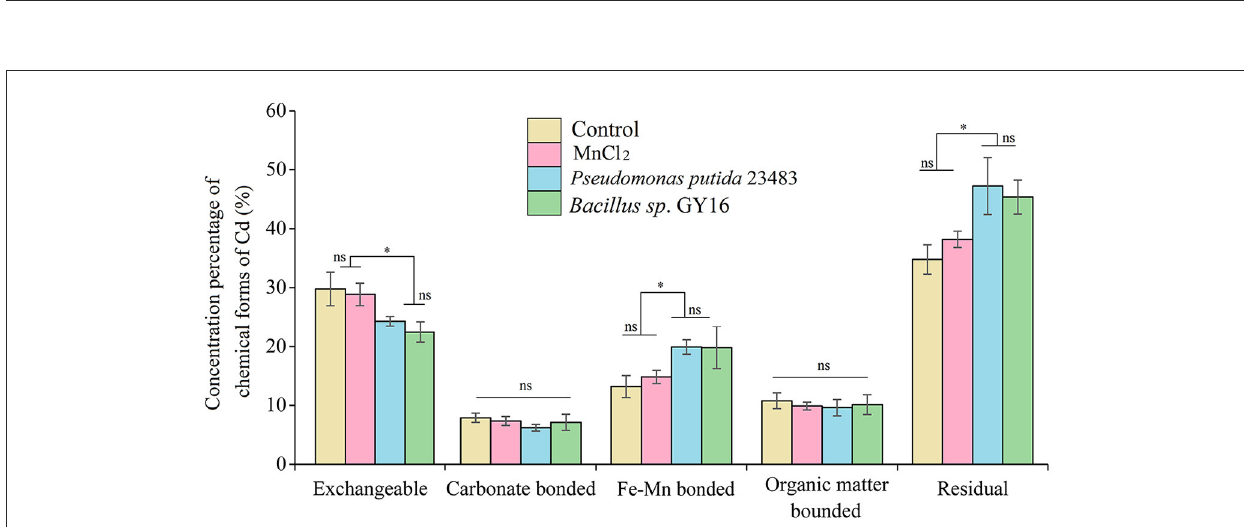
FIGURE5 Fractionation of Cd in soil without or with inoculation of microbial strains Pseudomonas putida 23483 and Bacillus sp. GY16. Bars with an asterisk (*) indicate significant differences among treatments determined by Tukey’s HSD test at P < 0.05, and “ns” means not significant.